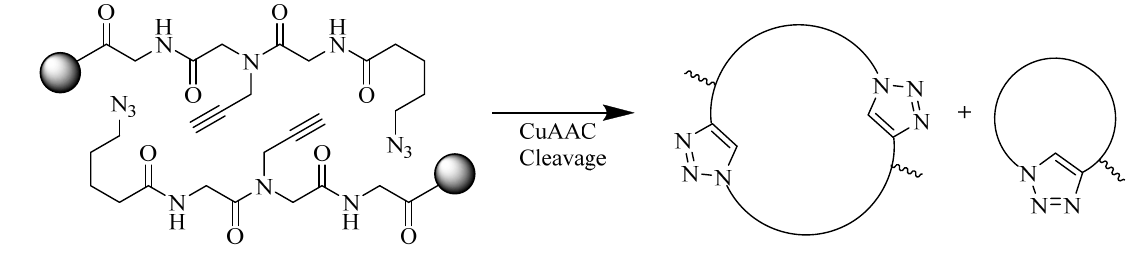
Figure 12. Head-to-tail CuAAC conjugation producing cyclodimer or cyclomonomer.